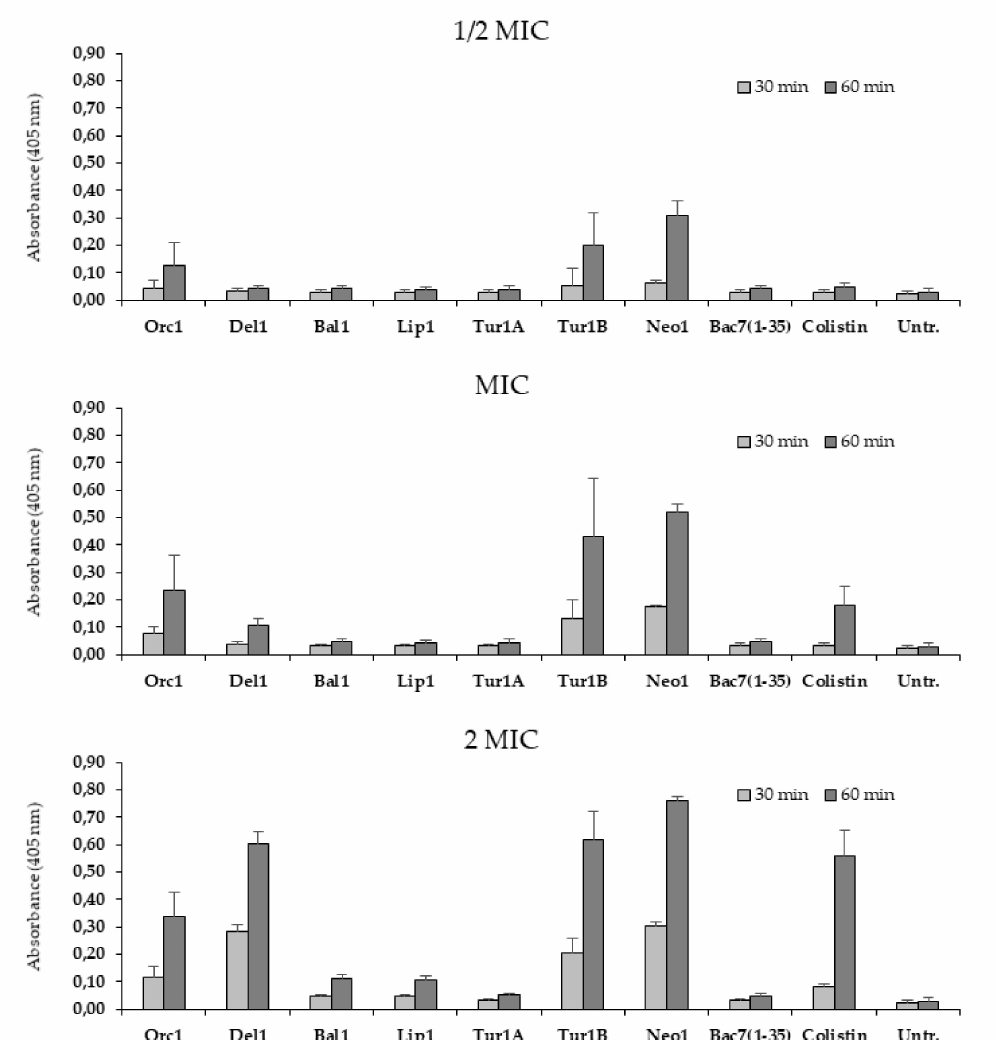
Figure 2. Cytoplasmic membrane permeabilization of E. coli ML35p by cePrAMPs. Peptide-mediated × MIC, 1 × MIC and 2 × MIC. Inner membrane permeabilization was membrane permeabilization at 1 2 monitored as an increase in absorbance at 405 nm by O-nitrophenol, a product of the hydrolysis of the impermeable, chromogenic substrate ONPG after 30 (cid:48) and 60 (cid:48) incubation. The membranolytic peptide antibiotic colistin has been used for comparison. The complete kinetics of permeabilization are shown in Figure